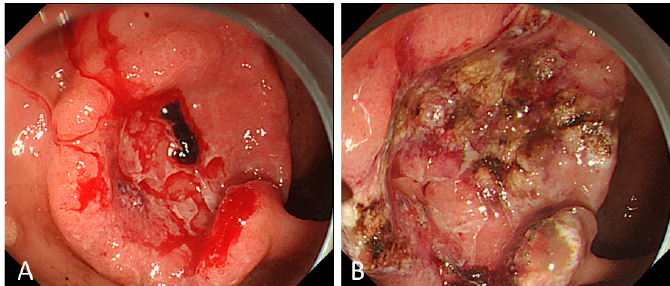
Figure 2. Endoscopic therapy for gastric cancer bleeding. Argon plasma coagulation (APC) was